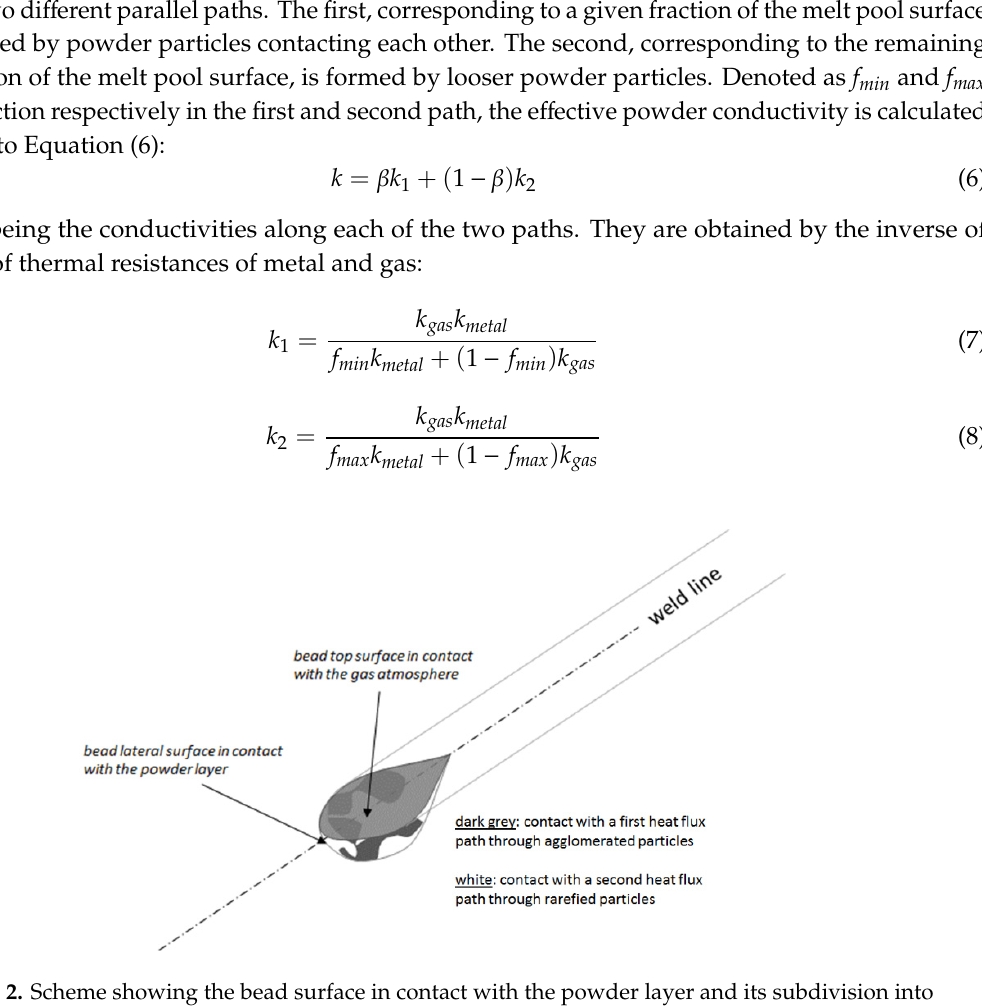
Figure 2. Scheme showing the bead surface in contact with the powder layer and its subdivision into regions contacting powder–gas mixture zones having different density.